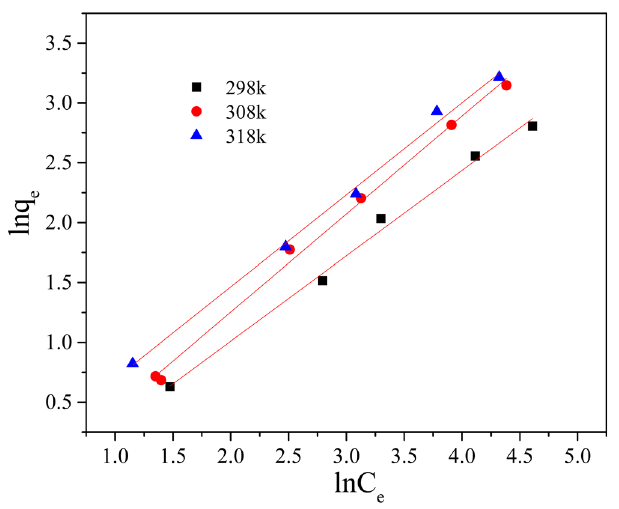
Figure 15. The Freundlich adsorption isotherm.